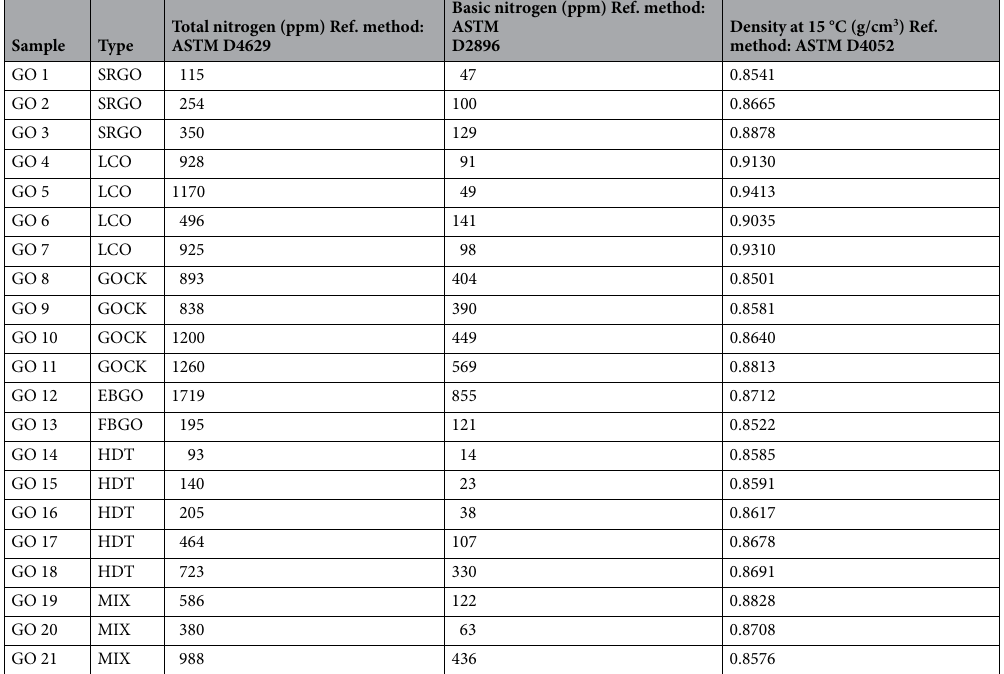
Table 1. Macroscopic properties of gas oil samples used in this study. The neutral nitrogen content is calculated by deducting the basic nitrogen from the total nitrogen content. The ASTM standard methods used for analysis are mentioned for each property. SRGO straight run gas oil, LCO light cycle oil, GOCK coker gas oil, EBGO gas oil from ebullating bed hydroprocessing reactor, FBGO gas oil from fixed bed hydroprocessing reactor, MIX blended gas oil, HDT